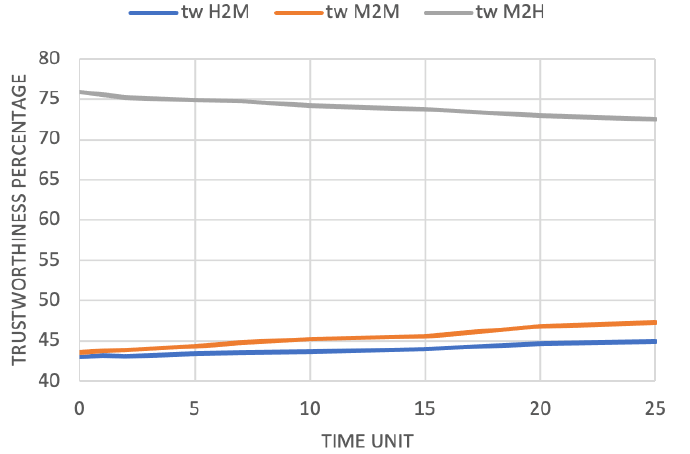
Figure 4. Average trustworthiness evaluation in the trustworthiness-based scenario after 500 time units with 25% request probability, as the error probability